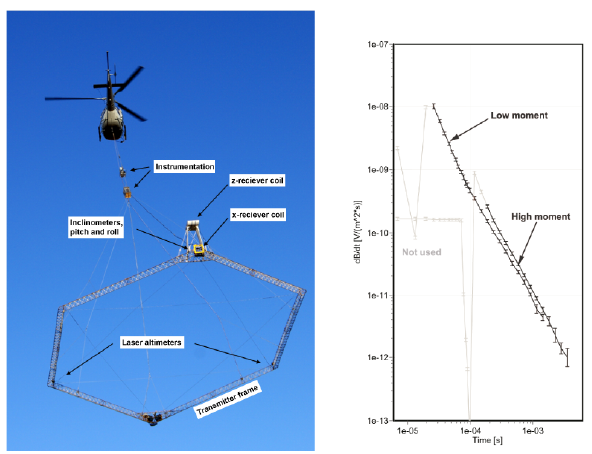
Fig. 4. Left: SkyTEM system. Right: example of a data curve di- vided into two moments, one giving information of the near-surface in the early times (Low Moment – LM) and the other one complet- ing the sounding model in the deeper part with measurement at the late times (High Moment –